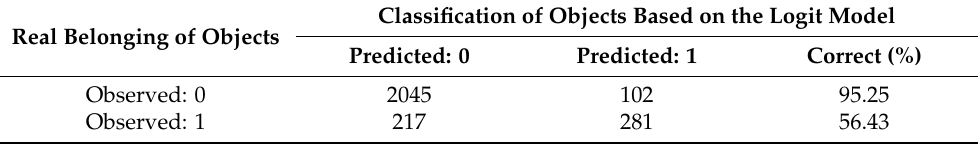
Table 6. Matrix of case classification—Polish Industry. Classification of Objects Based on the Logit Real Belonging of Objects